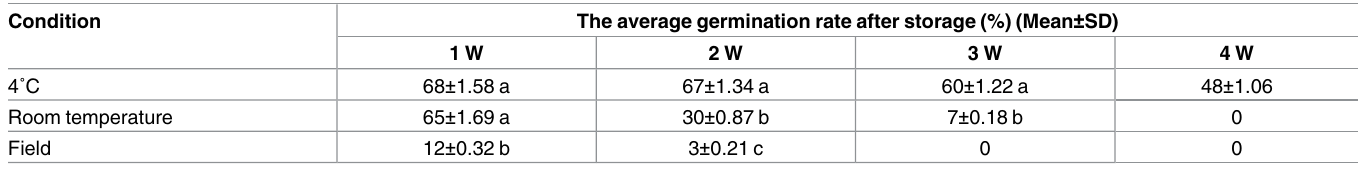
Table 2. The averagegermination rate of Bt poplar seeds after storage.